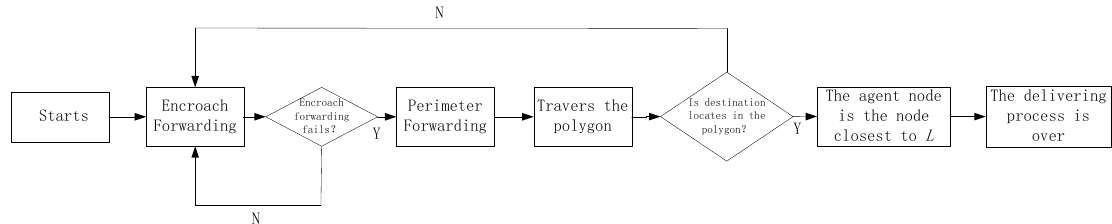
Figure 8. The flowchart of delivering a package from the source node to the agent node.